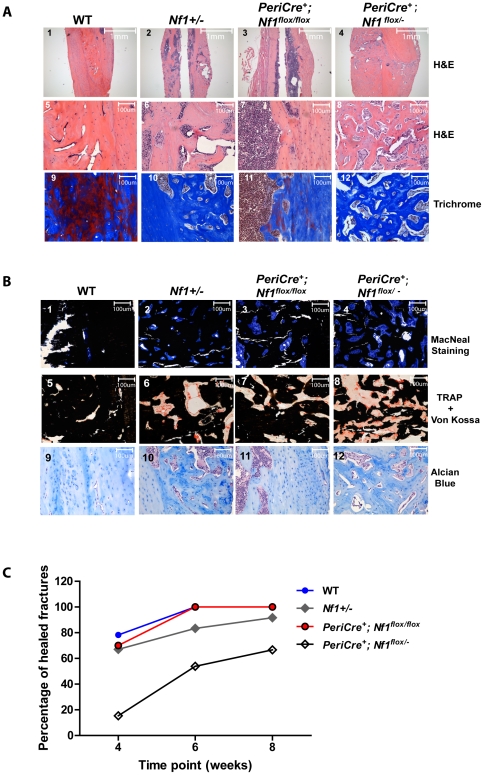

PeriCre+;Nf1flox/− mice have a delayed fracture healing process.(A) H&E staining (upper and middle panels 1–4, 5–8) and Masson Trichrome staining (lower panels10–12). (B) McNeal/von Kossa staining (upper panels1–4), TRACP/Von Kossa (middle panels 5–8), and Alcian blue staining (lower panels 9–12) of the tibia 4 weeks after the fracture. (C) Percent of healed fractures at a series of time points.